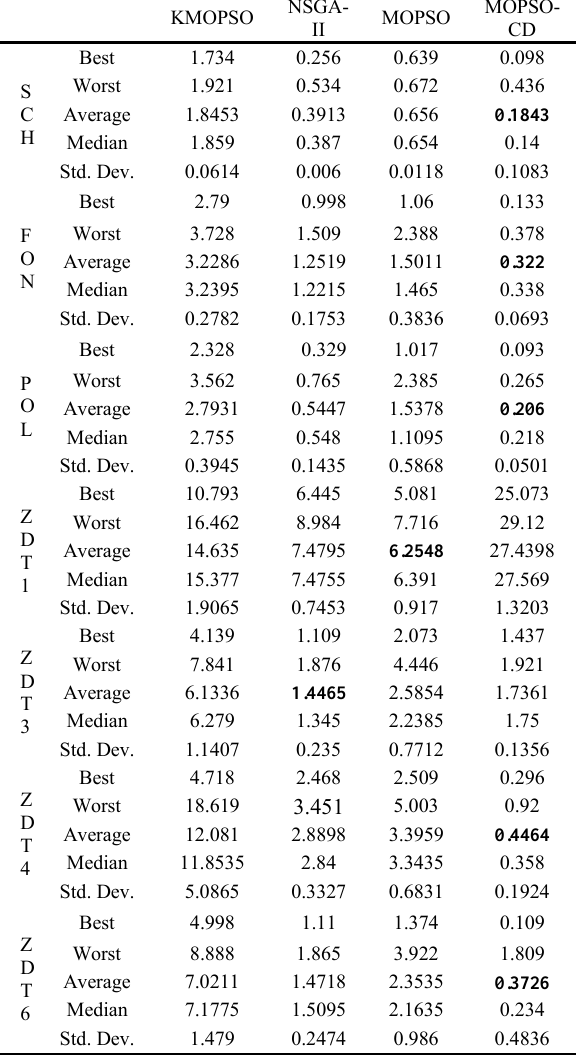
Table 23 . Computational time (in seconds) of three